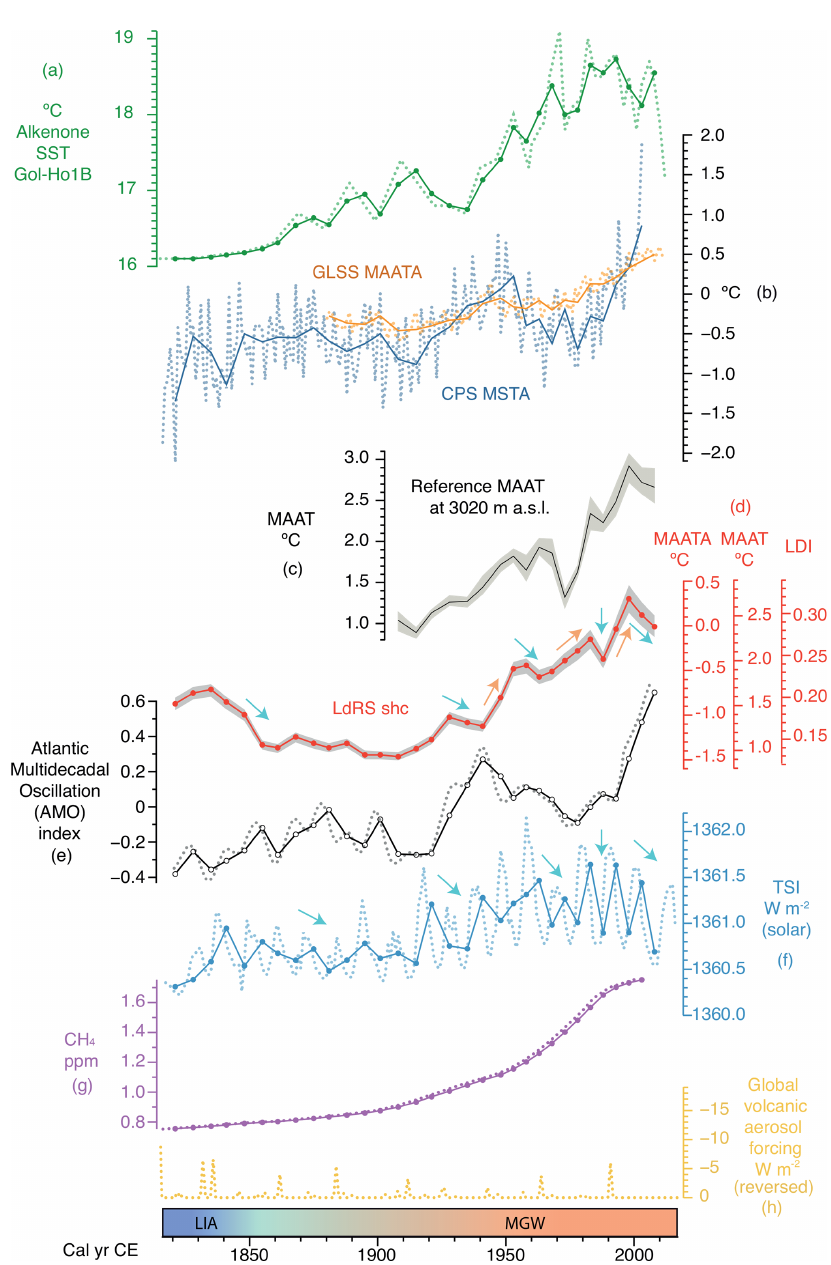
Figure 5. Comparison of the LDI record and the reconstructed temperatures for the last ∼ 200 years of LdRS with marine and terrestrial temperature records, Atlantic multidecadal oscillations, greenhouse gases, solar radiation, and volcanic eruption records. Original data are shown by dashed lines. Solid lines represent the same time averaging as the LDI data in LdRS shc (data were linearly interpolated and time averaged to the same resolution as the sampling points of LdRS shc) to facilitate the correlation. (a) Alkenone-derived sea surface temperatures (SST, ◦ C) of the core Gol-Ho1B_KSGC-31 (Gulf of Lion: NW Mediterranean Sea; Sicre et al., 2016). (b) Composite-plus- scaling (CPS) mean summer temperature anomaly reconstruction from tree-ring records in Europe with respect to 1974–2003 (MSTA, ◦ C) (Luterbacher et al., 2016) as well as global land and sea surface (GLSS) mean annual temperature anomalies with respect to 1979–2008CE (MAATA, ◦ C) (Hansen et al., 2010). (c) Summary of the four reference temperature time series at 3020ma.s.l.: gray shading shows the maximum and minimum temperature ranges, and the black solid line represents the mean temperature values; (d) LDI record along with the reconstructed mean annual air temperatures (MAAT, ◦ C) and mean annual air temperature anomalies with respect to 1979–2008CE (MAATA, ◦ C) for the last ∼ 200 years in LdRS; (e) Atlantic Multidecadal Oscillation (AMO) reconstruction (Mann et al., 2009); (f) high- resolution total solar irradiance reconstruction (TSI, Wm − 2 ) (Coddington et al., 2016); (g) reconstructed concentration of atmospheric CH 4 (ppm) (Schmidt et al., 2011); and (h) reconstruction of the global volcanic aerosol forcing (Wm − 2 ) (reversed) (Sigl et al., 2015). Acronyms: LIA, Little Ice Age; MGW, modern global warming. Blue arrows: decrease; orange arrows: